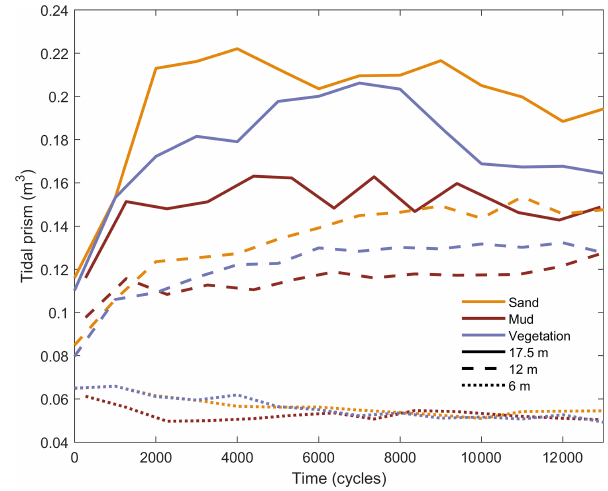
Figure 10. Tidal prism along the experimental estuaries calculated with the flow model after (a) 6000 and (b) 13000 tidal cycles. The estuary mouth is located at 17.8m.